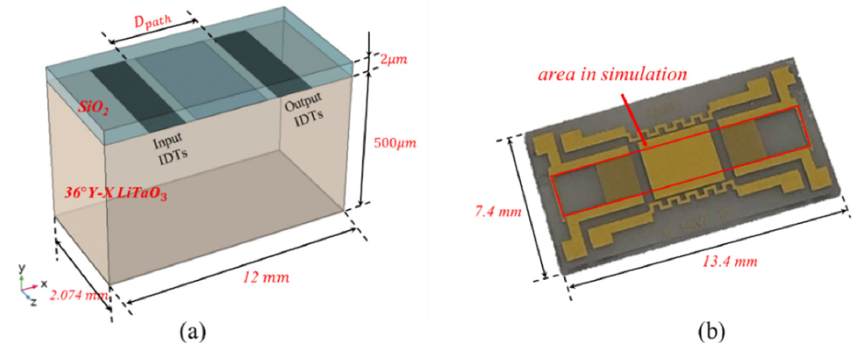
Figure 1. ( a ) Three-dimensional model of the device used in numerical simulation. ( b ) Fabricated SH-SAW chip without SiO 2 layer. The selected area for simulation is marked with the red rectangle.